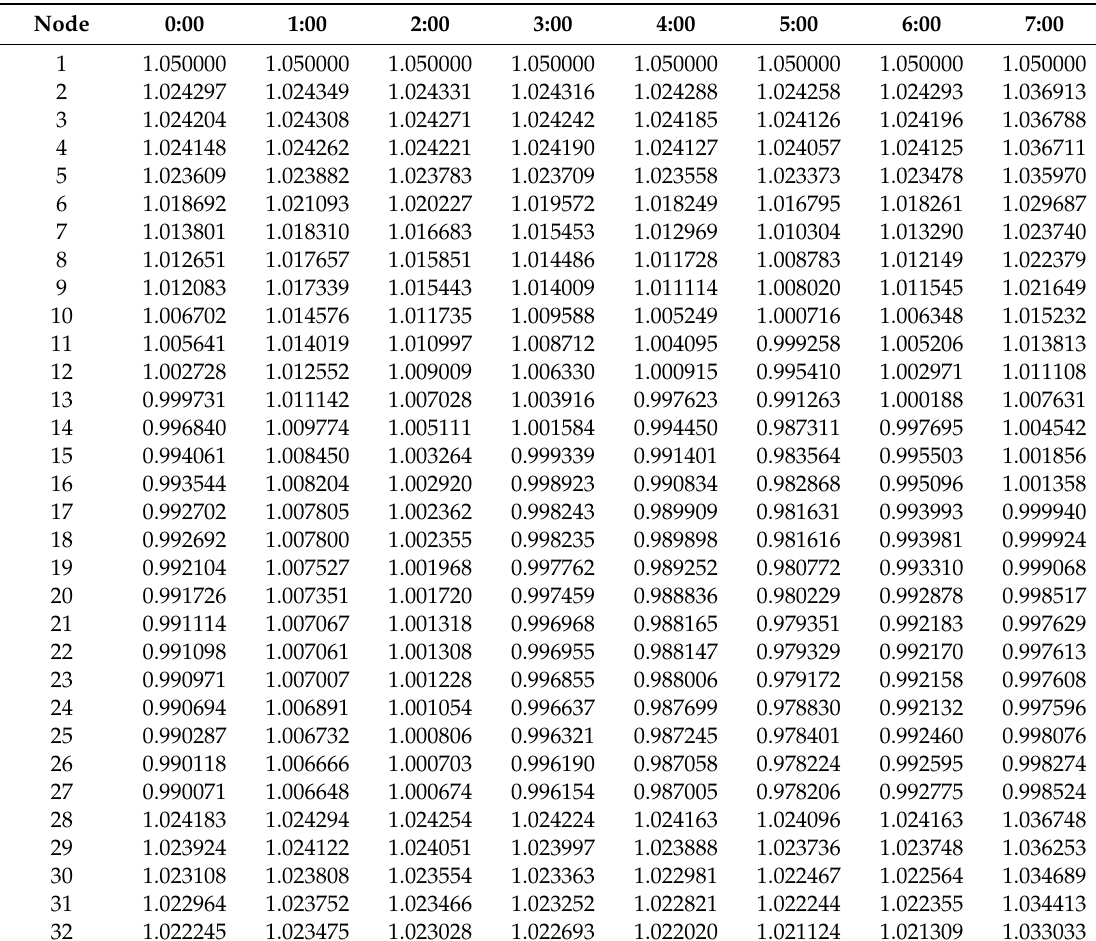
Table A3. Voltage results obtained by S2 of Case 1